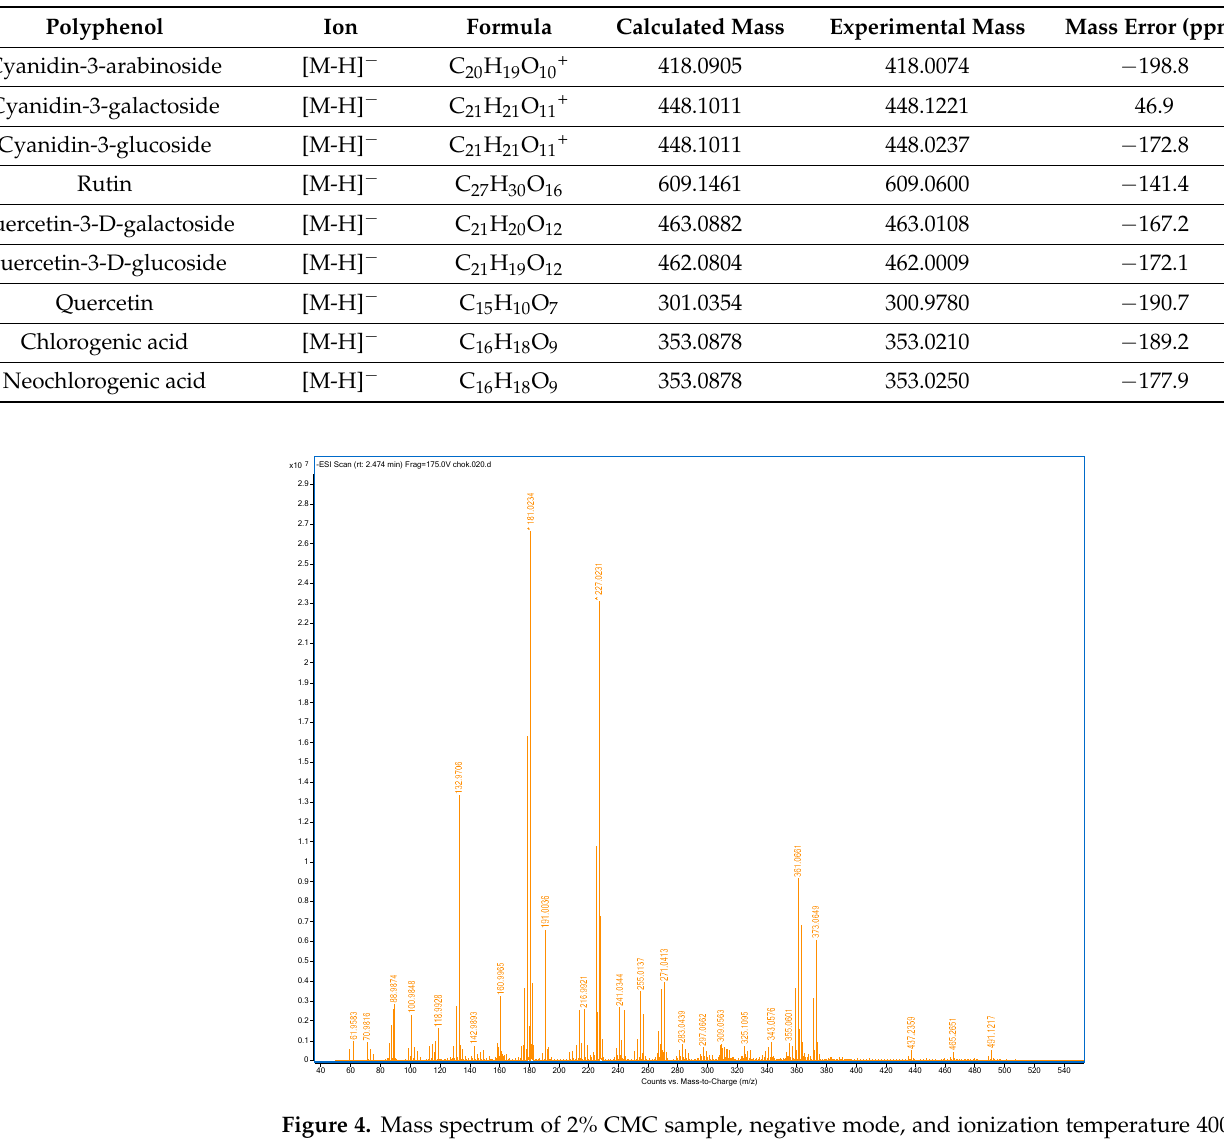
Table 2. Calculated and experimental masses for evaluated standards of polyphenols obtained by DART-TOF/MS in negative mode.